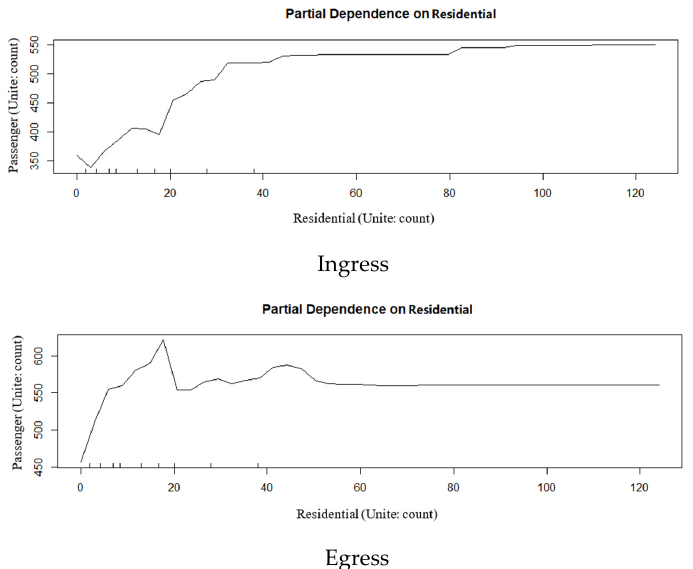
Figure 16. Partial dependence plot of residential area.